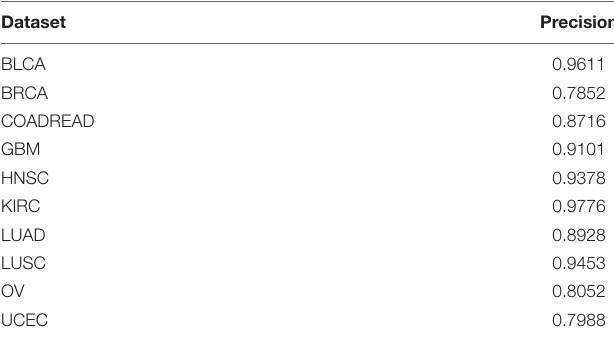
TABLE 2 | Classification accuracy for each cancer with XGBoost classifier on training datasets via 10-fold cross-validation.